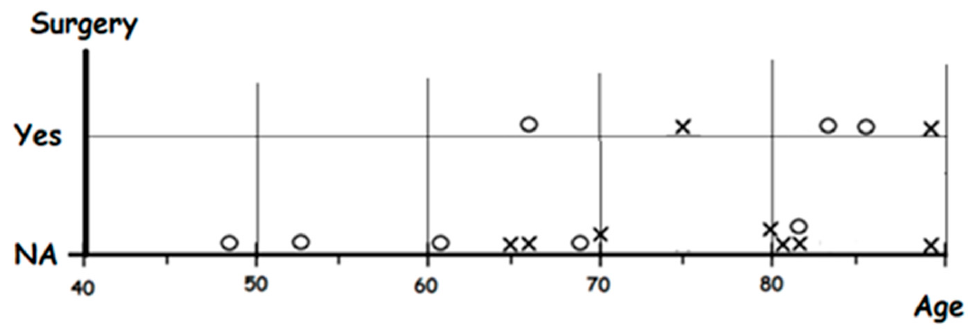
Figure 13. Decision tree obtained from the scatter graph.